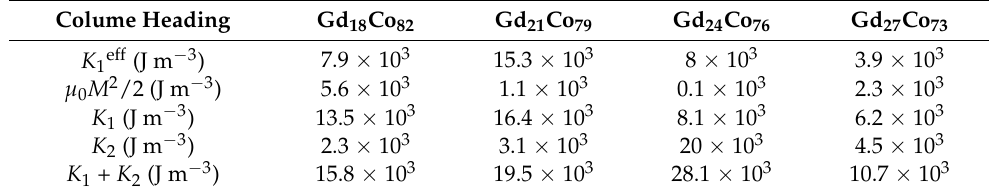
Figure 3. AHE results. The normalized AHE voltage ( m z ) of the ( a ) Gd 18 Co 82 , ( b ) Gd 21 Co 79 , ( c ) Gd 24 Co 76 , and ( d ) Gd 27 Co 73 alloys. The magnetic field is applied with an oblique angle, θ H , with respect to the film normal direction. The black/red color corresponds to the θ H of 0 ◦ /85 ◦ . The GST analysis of the ( e ) Gd 18 Co 82 , ( f ) Gd 21 Co 79 , ( g ) Gd 24 Co 76 , and ( h ) Gd 27 Co 73 alloys. The black squares are the data obtained from ( a – d ) with θ H of 85 ◦ . The red lines are fittings with Equation (1). The fitted values of the uniaxial anisotropy are summarized in Table 1. Table 1. The first-order ( K 1 ) and second-order ( K 2 ) uniaxial anisotropy of the GdCo alloy, with the Gd concentration of 18%, 21%, 24%, and 27%. The K 1eff and K 2 values are determined from the linear fitting of Figure 2e–h. The K 1 values are obtained from K 1eff by K 1 = K 1eff + µ 0 M 2